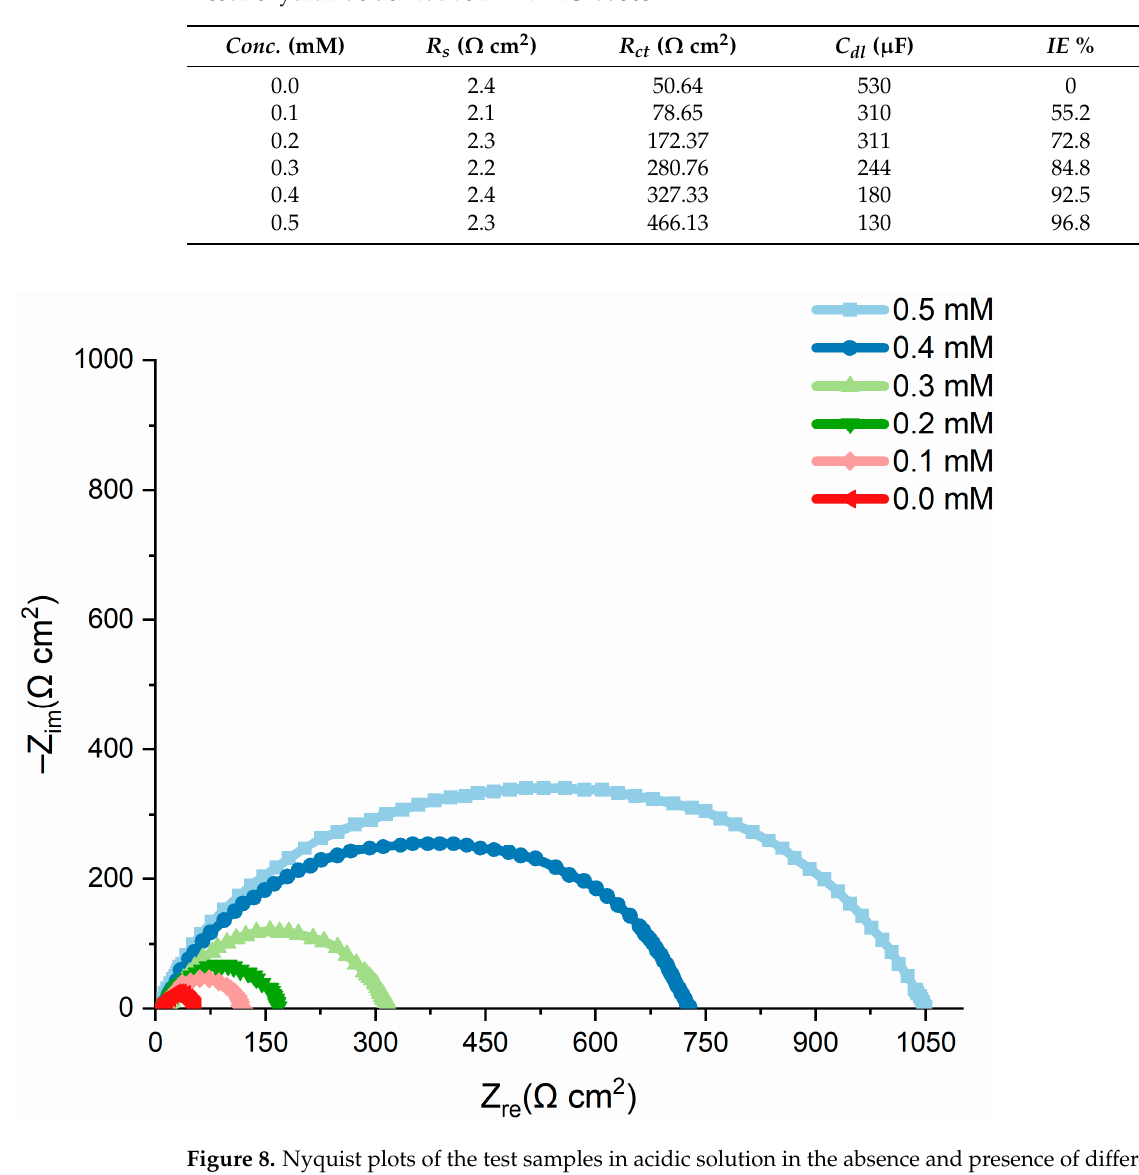
Table 2. EIS parameters for steel sample in absence and presence of various concentrations of nicotinehydrazide derivative in 1 M HCl at 303 K.